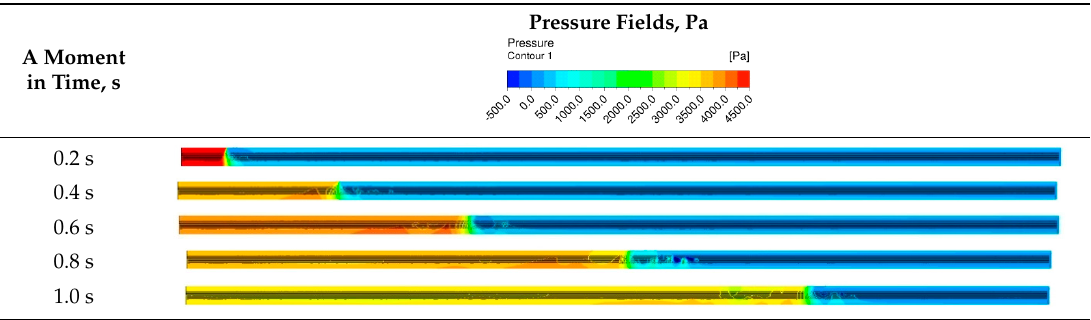
Table 3. Pressure fields.